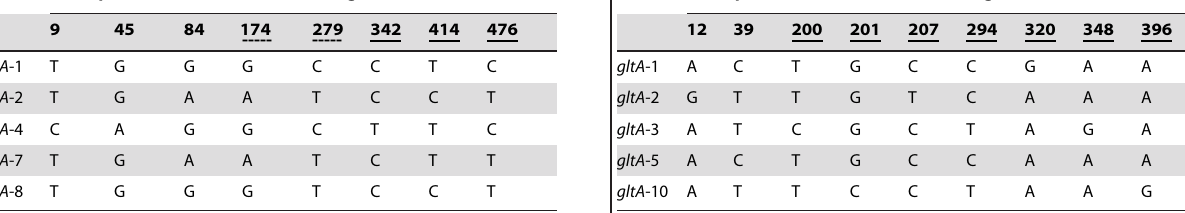
Table 1. SNPs in aspA locus fragments.